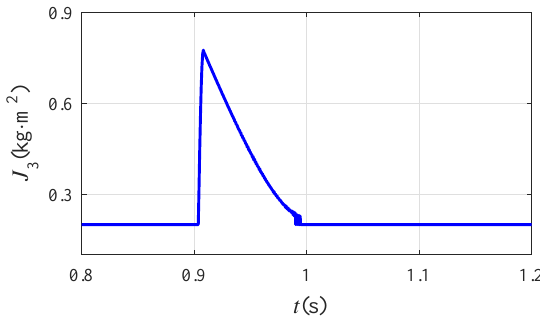
Figure 18. Variation of virtual inertia when disconnected from the